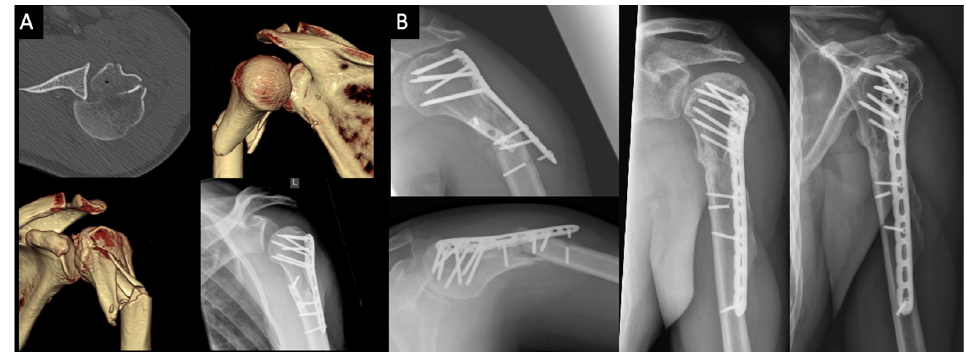
Figure 4. 39-year old male bicyclist that collided with a motor vehicle; ( A ) axial CT scan and 3D reconstruction of a posteriorly dislocated surgical neck fracture with an additional reverse Hill-Sachs lesion; ( B ) secondary dislocation with screw failure (left) and final result after surgical revision 5.5 years after the index injury (right).